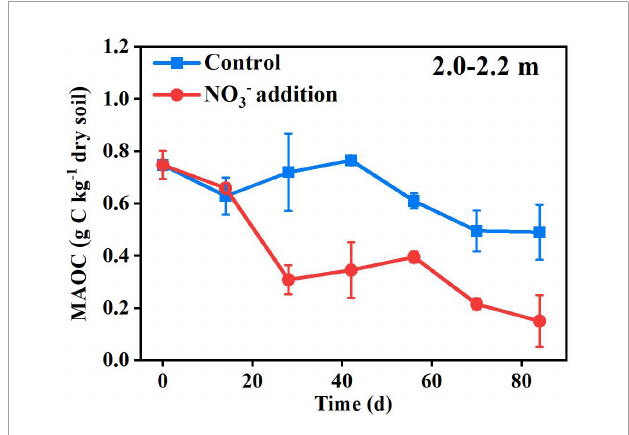
FIGURE6 Nitrate addition effects on the content of MAOC in the 2.0–2.2 m depth over time in Experiment 5. Data are shown as the mean ± standard deviations ( n =